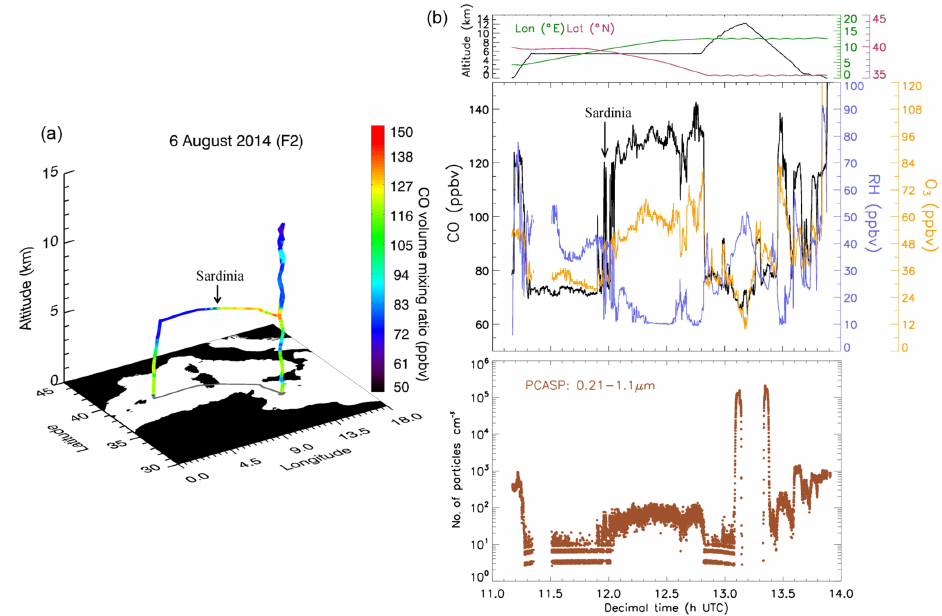
Figure 5. Flight F2 (6 August 2014). (a) Three-dimensional trajectory colour-coded according to CO vmr between Menorca and Lampedusa. (b) Top – Flight altitude, longitude and latitude as a function of time; middle – time series of CO (black) and O 3 (orange) vmr and relative humidity (blue); bottom – aerosol total number concentrations